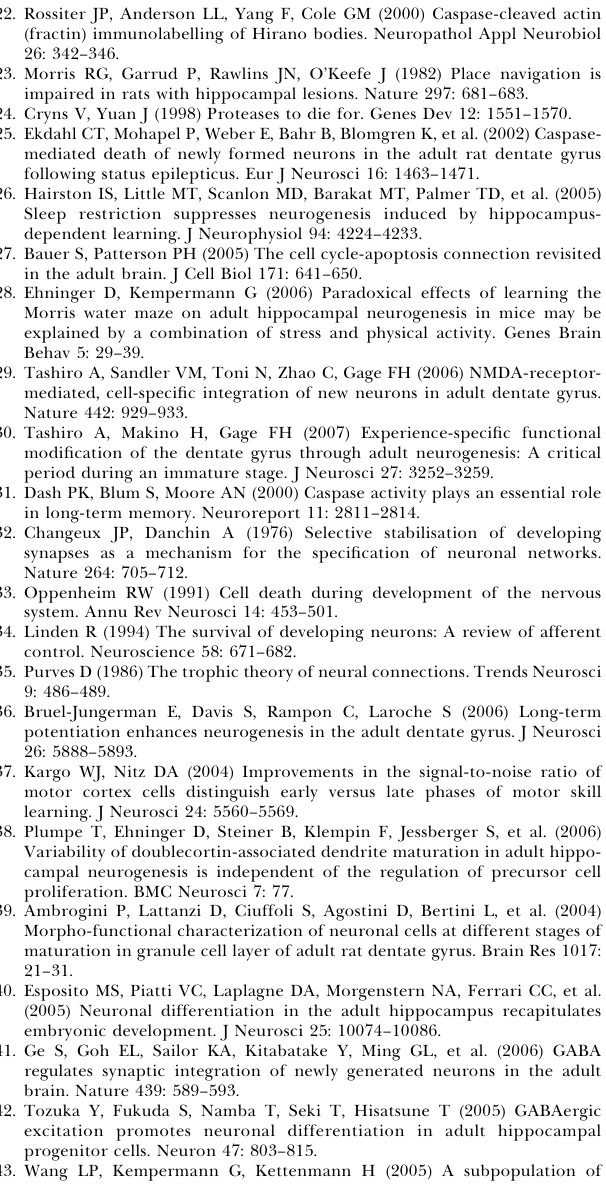
Table S4. Time Course of the Influence of Learning on the Number of BrdU-IR Cells Spatial learning had no effect on the number of newborn cells labeled with BrdU during the first 3 d of training (D1–D3, see Table S1). D, day. Table S5. Influence of zVAD Infusion during the Late Phase of Learning on the Probe Test and the Cued Test During the probe test, zVAD treatment impaired all the indices used to measure the efficiency of the swim paths to reach the goal location (time to goal, Wishaw’s index, and cumulative search error and path efficiency index). In contrast, during the cued test, zVAD treatment did not alter either visuomotor processes (average speed, and latency to reach the visible platform). Found at doi:10.1371/journal.pbio.0050214.st005 (11 KB